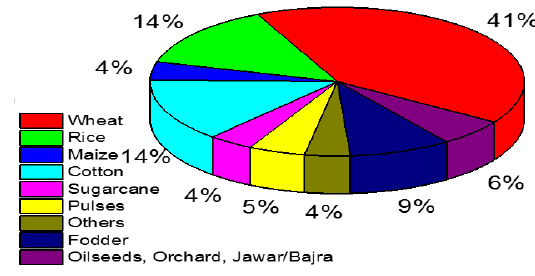
Fig. 8: Percentage of crop area under different crops